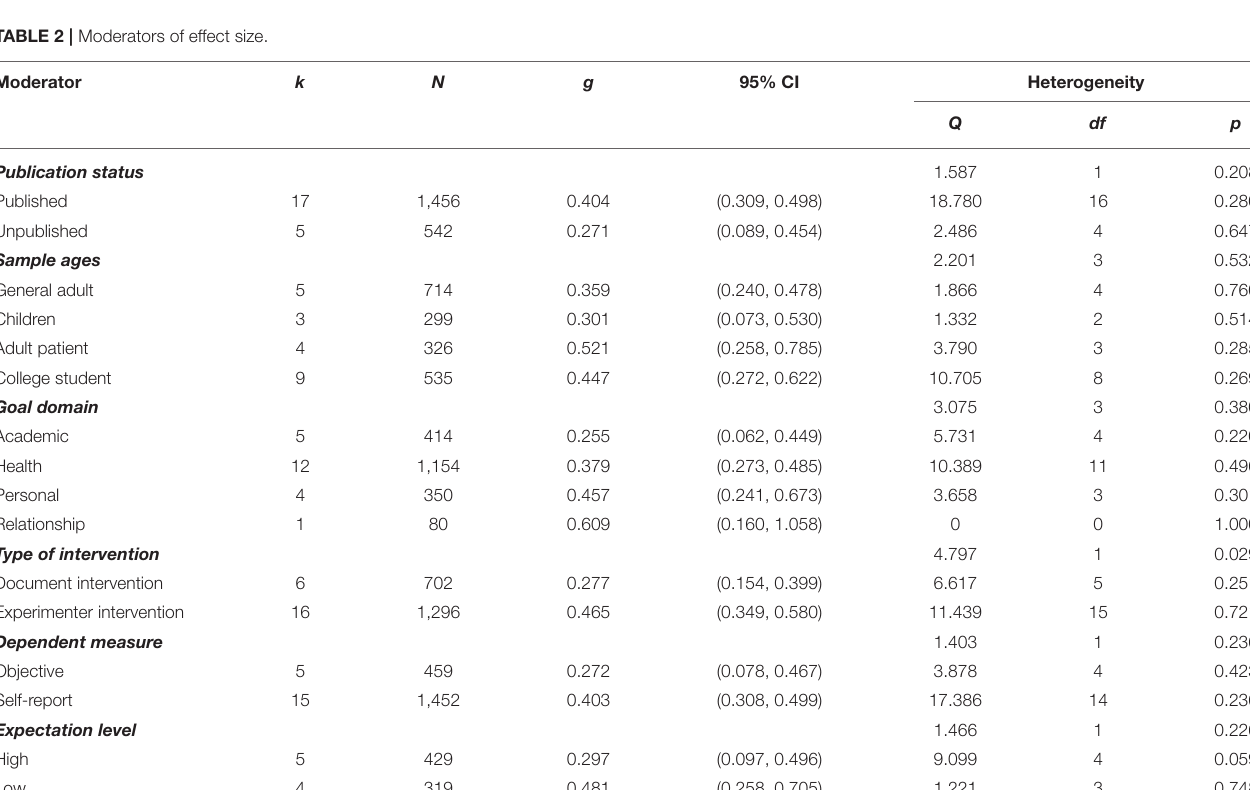
FIGURE 2 | Funnel plot of the MCII strategy on goal attainment.